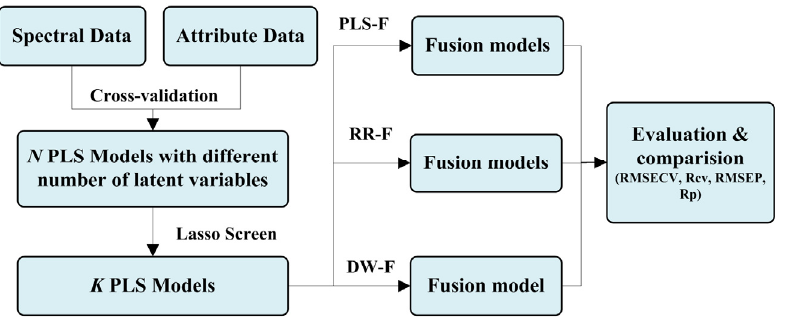
Figure 1. The framework of the proposed fusion strategy. Note: N and K stands for the number; PLS: partial least squares; PLS-F: partial least square regression coefficient fusion; RR-F: ridge regression coefficient fusion; DW-F: error weight fusion; Rcv: correlation coefficient of cross-validation; Rp: correlation coefficient of prediction; RMSECV: root mean squared errors of cross-validation; RMSEP: root mean squared errors of